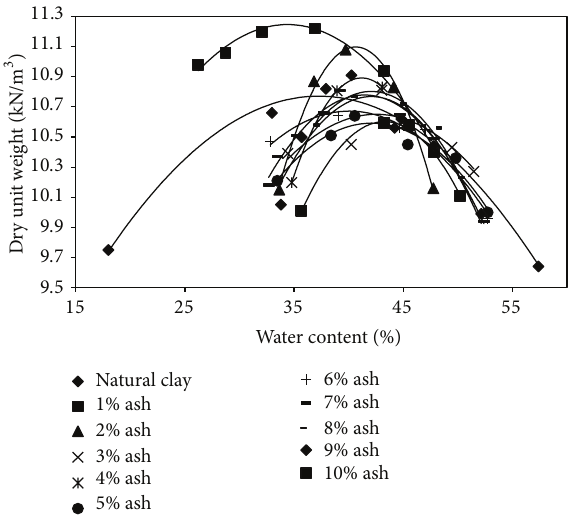
Figure 3: Compaction test results due to the addition of burned olive waste.